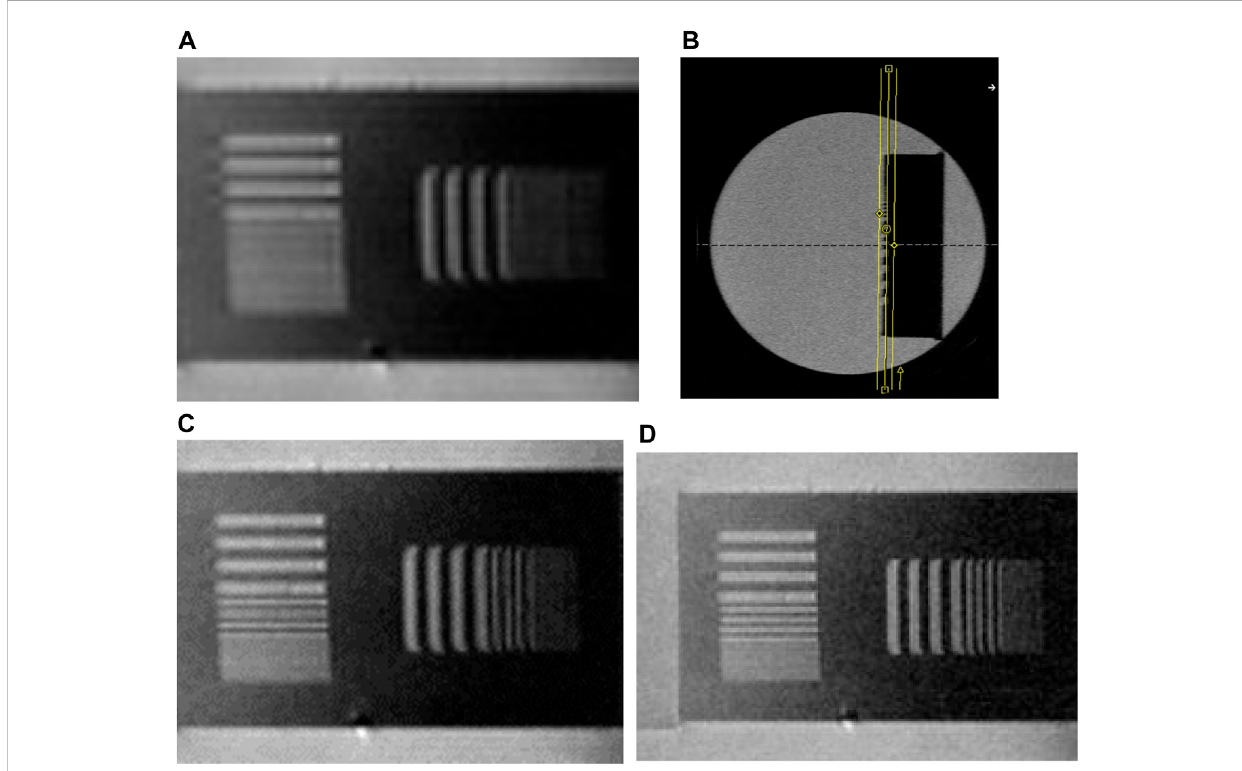
FIGURE 9 (A) In-plane(coronal)sliceselectiveMRM-scan(pixel-sizeps:78×78 μ m 2 ;slth=120 μ m;MatrixMtx:64×128,FOV:5×10 mm 2 ).Onlythegridwith periodicity a 1 /2 = 128 µm can be detected in frequency (x) and phase encoding direction (y). The smaller ones cannot be resolved. From qualitative inspectiontheresolution oftheMR-scan isproved to beatminimum 128 µm. (B) MR-axialscan ofthephantom usedas localizer for accurate placement of the MR-excited slice in the plane of the 2 orthogonal grids. The transverse (axial) scan crosses the vertical grid and thus allows for positioning of the slice. (C) In-plane slice selective MRM-scan (Voxel-Size VS.: 50 × 51 × 120 μ m 3 ). Mtx: 96 × 192, middle of 3 slices, phase encoding direction: (y). Only the grids with half periodicity a i /2 = 128 μ m, and 64 µm can be differentiated. The smaller ones cannot be resolved. From qualitative inspection the resolutionoftheMR-scan isproved tobeatminimum64 µm.Notetheapparently lowermodulationdepth forthesecondslit ofthea 2 /2=64 µmgridin phase-encoding (y-) direction which appears atlower intensity than theothermaxima due to partial volume coverageof thetinyslit by theneighbouring pixels. (D) In-plane (coronal) slice selective MRM-scan (ps: 39 × 39 μ m 2 , slth = 120 µm). Mtx: 128 × 256, middle of 3 slices, phase encoding direction: (y). Only thegridswith periodicitya 1 /2 = 128 μ m,and a 2 /2 =64 µmcan bedifferentiated. The partial volume coverageartefact, as observed in (C) for oneslit in phase encoding direction disappeared. The smaller grid lamellae cannot be resolved. From qualitative inspection the resolution of the MR-scan is proved to be at minimum 64